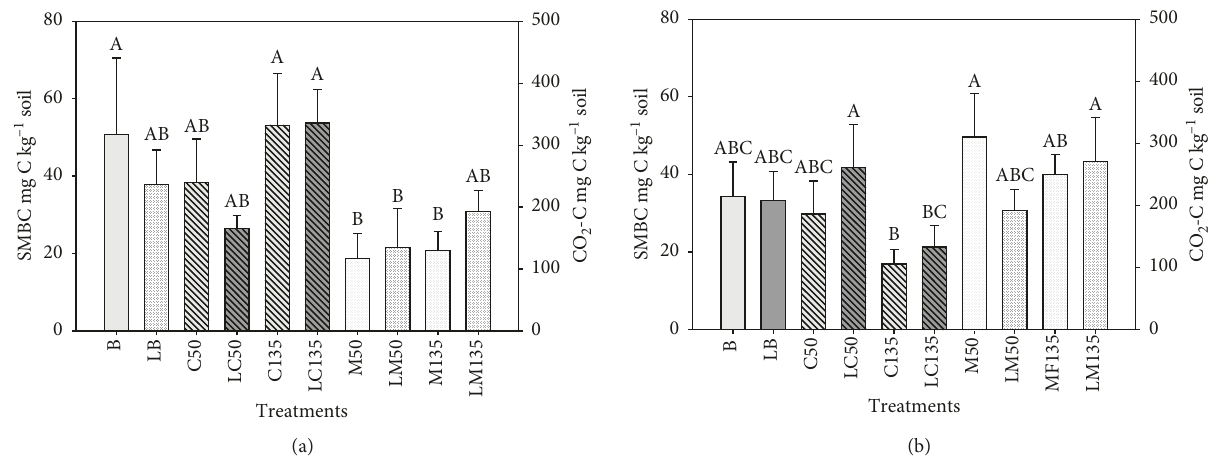
Figure 2: Left: soil microbial biomass (SMBC). Right: CO 2 flush. Treatments applied to biosolarized soils were bare control with no amendment (B), bar with LEM inoculant (LB), compost at 50kg · N · ha − 1 and at 135N · ha − 1 with and without LEM (C50, C135, LC50, and LC135), respectively, and mineral fertilizer at 50kg · N · ha − 1 and at 135N · ha − 1 with and without LEM (M50, M135, LM50, and LM135). Different letters indicate significant differences ( α �